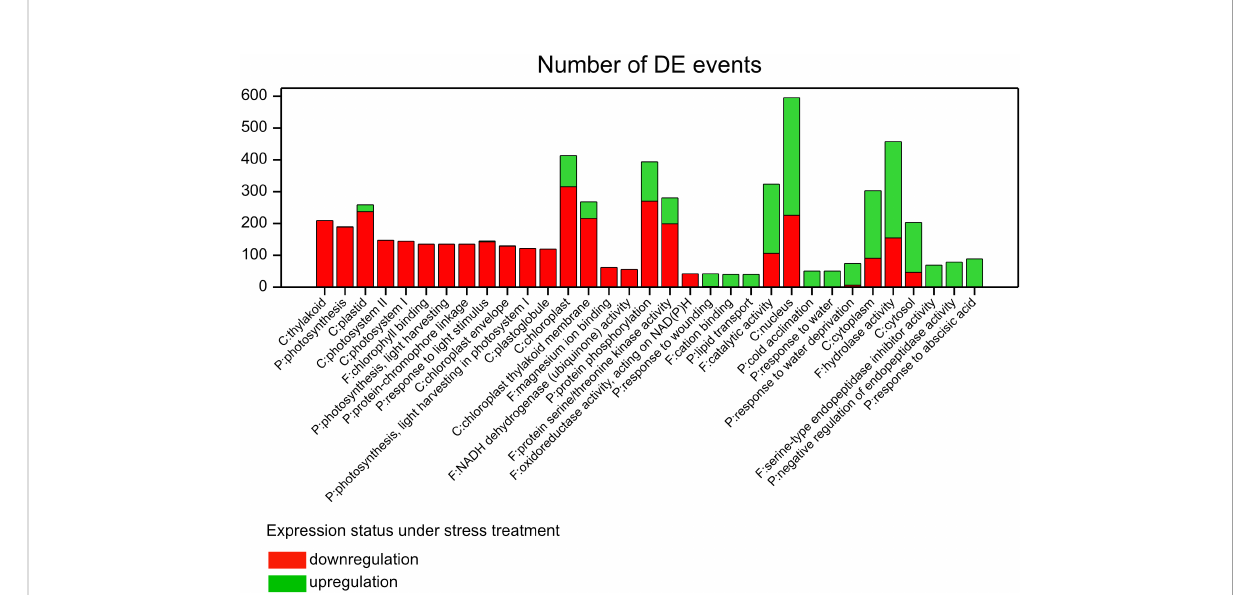
FIGURE 3 Enriched GO terms with assigned DE events whose distribution was signi fi cantly different than the marginal distribution of all DE events in the experiment ( c 2 test, P <0.001, |std. residual| >6); C, cellular component; F, molecular function; P, biological